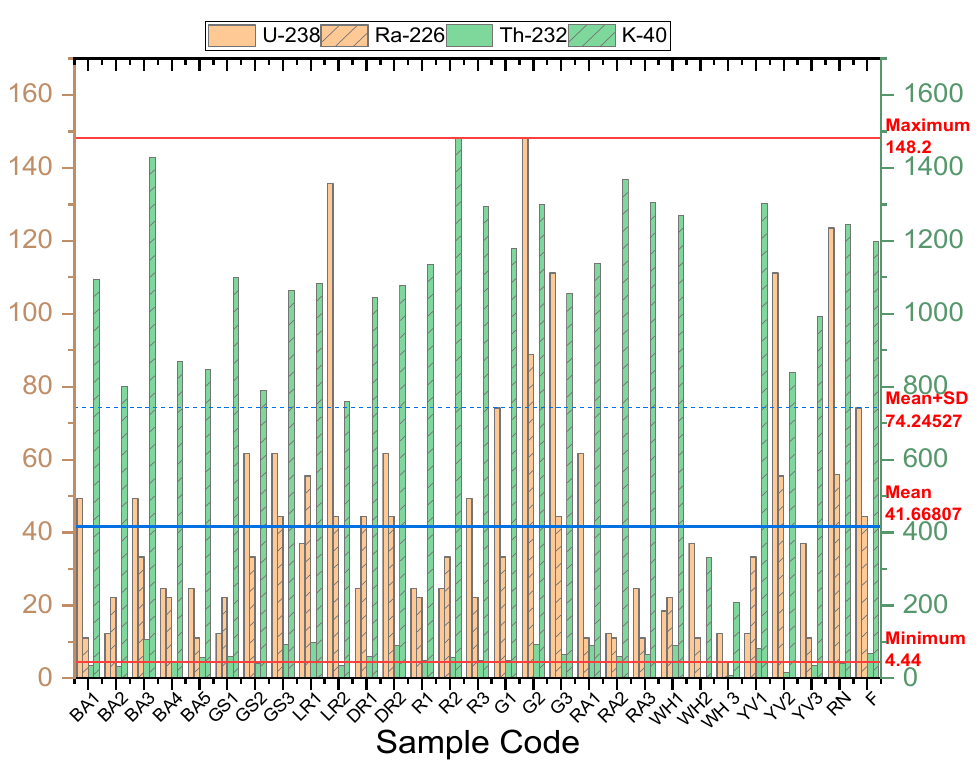
Figure 6. Activity concentrations (Bq kg − 1 ) of the radioelements ( 238 U, 226 Ra, 232 Th and 40 K) found in granitic rock samples (right scale is for 40 K).